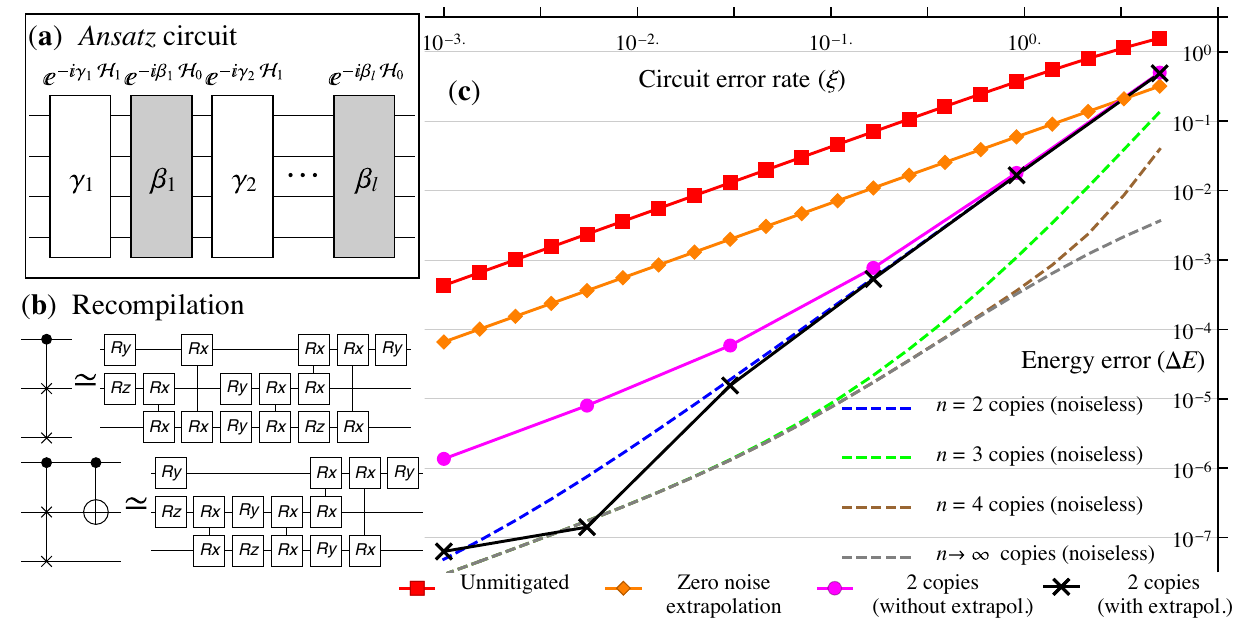
FIG. 4. (a) Ansatz used to prepare the ground state of the Hamiltonian in Eq. (8) for N ¼ 6 qubits. (b) Type B (type C) recompilation of controlled- SWAP (including observable) gates from Table I requires 5 (4) applications of the hardware-native entangling gates. (c) Error in estimating the ground-state energy with and without mitigation as a function of the number of expected errors ξ in the Ansatz circuit. We assume that the experimentalist can amplify the vast majority of the noise (94%) in the hardware-native gates, but not all of it, limiting extrapolation to a finite precision (orange diamonds). Although the derangement circuit is also degraded by noise, it can still drastically reduce errors both in combination with (black crosses) and without extrapolation (magenta dots). Dashed lines correspond to Tr ½ H ρ n (cid:2) = Tr ½ ρ n (cid:2) as obtained via noiseless derangement circuits. When increasing n , we approach in exponential order a nonzero error (dashed gray line) which is due to the coherent mismatch in the dominant eigenvector. The present demonstration on 2 × 6 þ 1 qubits should rather be viewed as a worst-case scenario since increasing the scale of the computation will favor the ESD